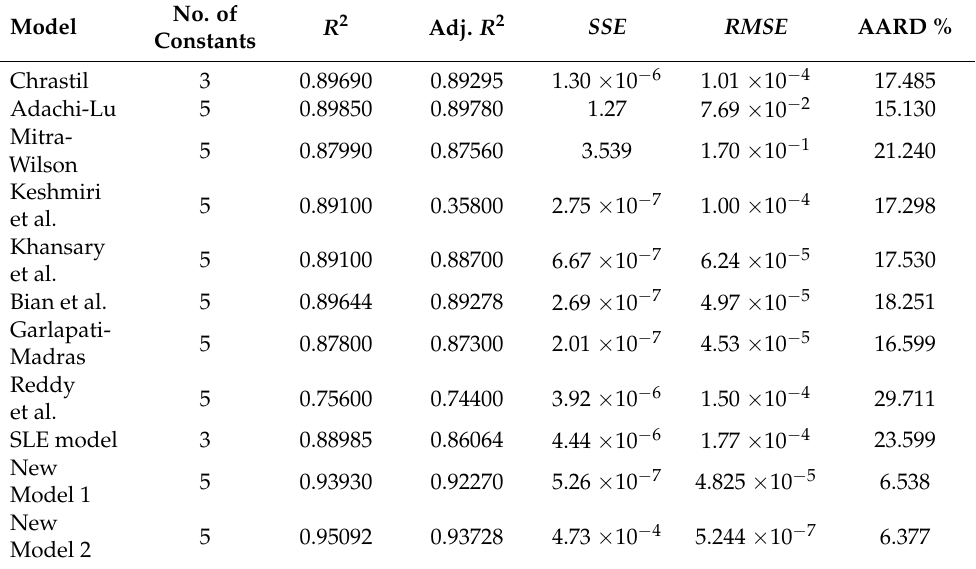
Table 6. Overall mean statistical parameters of solubility